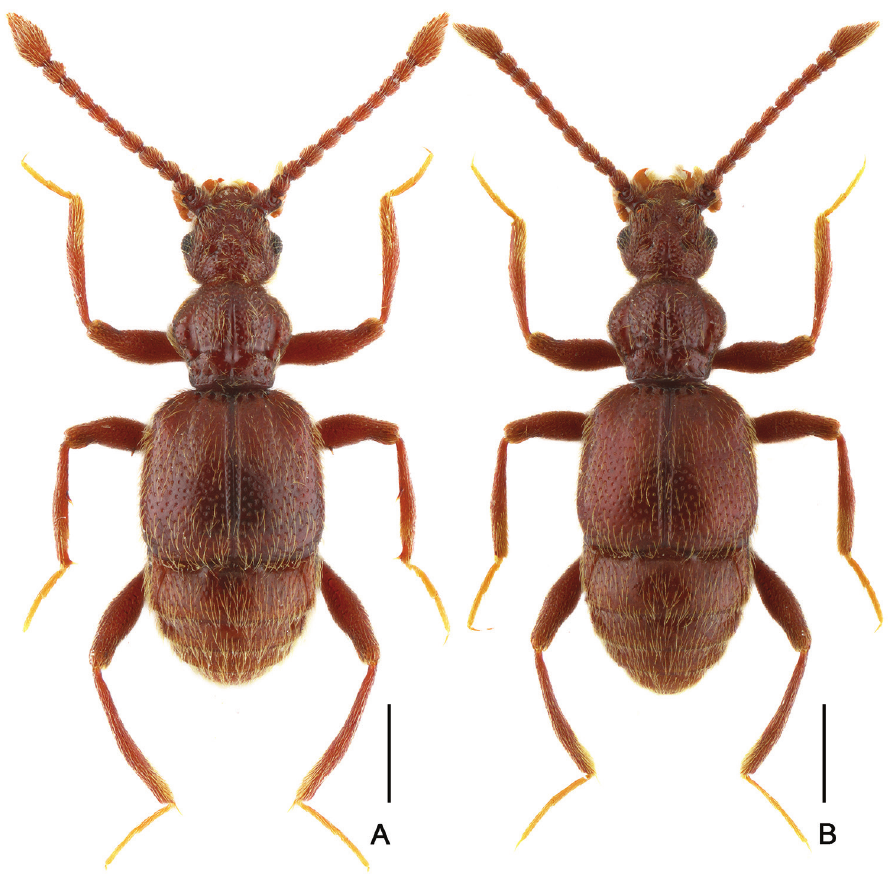
Figure 2. Dorsal habitus of Batrisodes grossus . A Male B Female. Scale bars: 0.5 mm. Mesotrochanter (Fig. 3B) with distinct triangular short spine; mesofemora (Fig. 3B) with thin but distinct ventral spine at middle; mesotibiae (Fig. 3C) with small ventral denticle near middle and an acute triangular apical spine. Abdomen wider than long, AL 0.73 mm, AW 0.85 mm; tergite IV longest, approximately 1.5 times as long as next, with strongly oblique marginal carinae. Length of aedeagus (Fig. 3D–E) 0.35 mm; median lobe simple, flattened, apical obviously expanded, nearly symmetrical. Female (Fig. 2B). Similar to male, antennomere III–V normal; each eye composed of about 40 facets; legs lacking denticle and spine; tergite VIII (Fig. 3F) semicircular; sternite VIII (Fig. 3G) transverse; symmetrical genital complex (Fig. 3H) slightly scle- rotized. Measurements of body parts: BL 2.45–2.53 mm, HL 0.45–0.46 mm, HW 0.50–0.51 mm, PL 0.49–0.52 mm, PW 0.58–0.60 mm, EL 0.81–0.84 mm, EW 0.87–0.88 mm, AL 0.70–0.71 mm, AW 0.83–0.84 mm. Distribution. Southwestern China: Yunnan. Host ant. Odontomachus